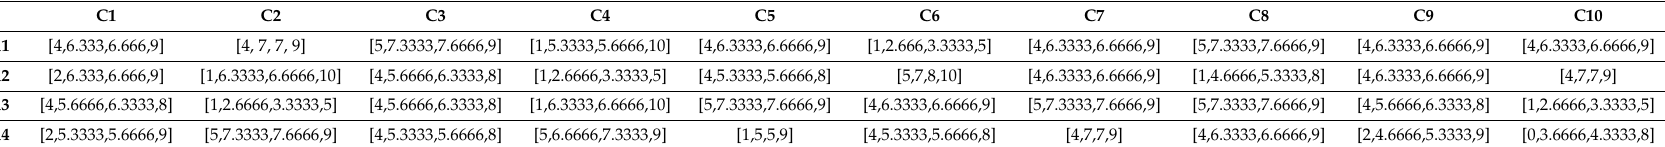
Table 8. Aggregated fuzzy decision matrix.